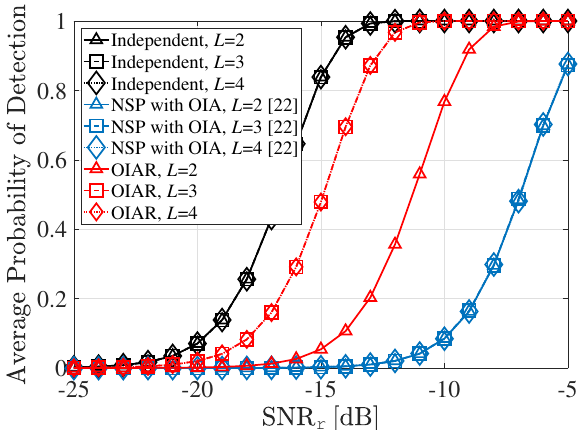
Figure 7. Average probability of detection performance according to SNR r with different L